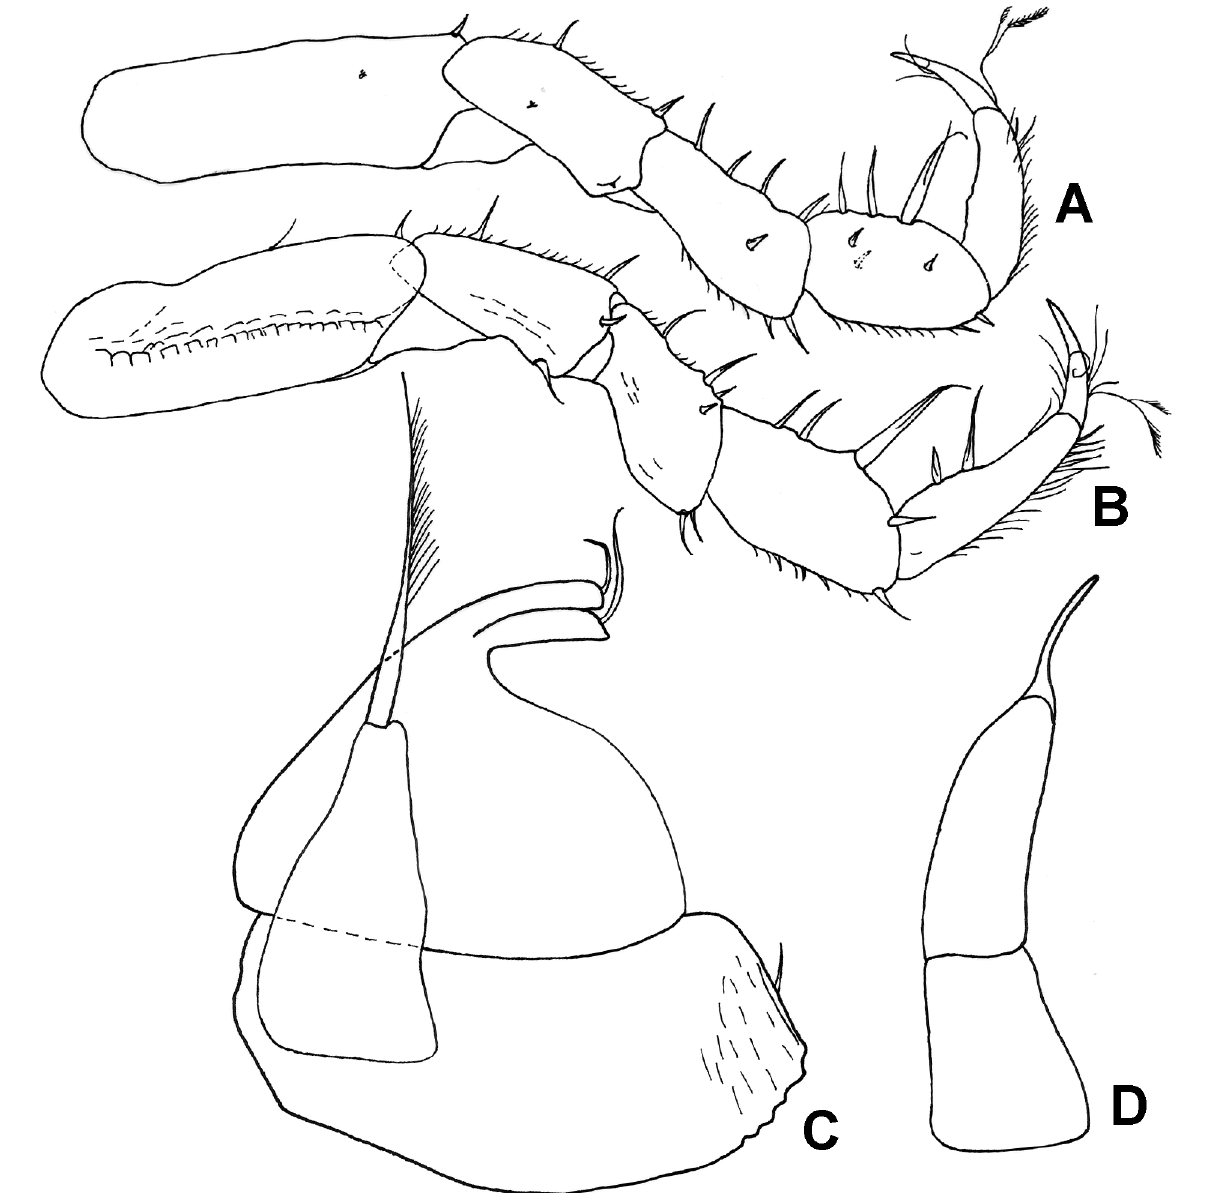
Fig. 6. Trichoniscoides bellesi Reboleira & Taiti sp. nov. from Algar do Javali, Montejunto, paratype, ♂. A . Pereopod 1. B . Pereopod 7. C . Pleopod 1. D . Pleopod 2